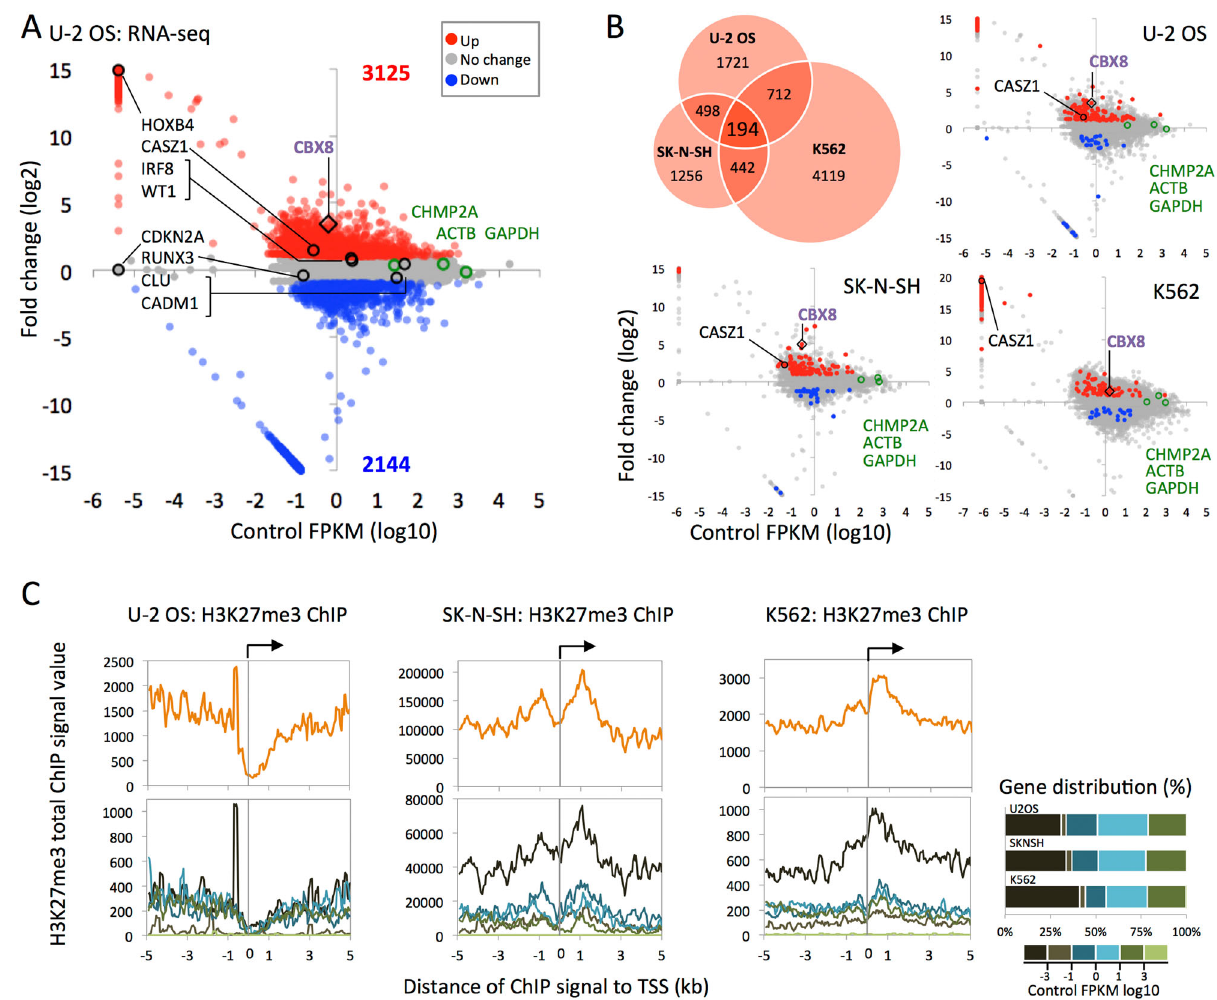
Fig. 2 Genome-wide analysis of gene transcription and H3K27me3 at promoter regions in PcTF-expressing cells. a The scatter plot compares RNA-seq signals (FPKM log 10 ) of 23,245 genes from cells that were mock transfected (Control) vs. log 2 fold change of PcTF-expressing cells 96 h post-transfection for U-2 OS and SK-N-SH and 48 h for K562. Housekeeping genes GAPDH , ACTB , and CHMP2A are negative controls. b The Venn diagram shows unique and common sets of genes that became up-regulated at least twofold in the three cell types. Overall, 194 commonly up-regulated genes and 50 commonly downregulated genes are highlighted in the scatter plots. The PcTF-homologous CBX8 gene was used as a proxy for PcTF expression levels. c TSS plots ( orange , top ) show total H3K27me3 ChIP enrichment values mapped at 200 bp intervals with a step value of 50 bp. In the lower plots, values are strati fi ed by the basal gene expression level in untreated cells (Control FPKM log 10 ). Strati fi ed TSS-plot data were normalized by the gene distribution for each